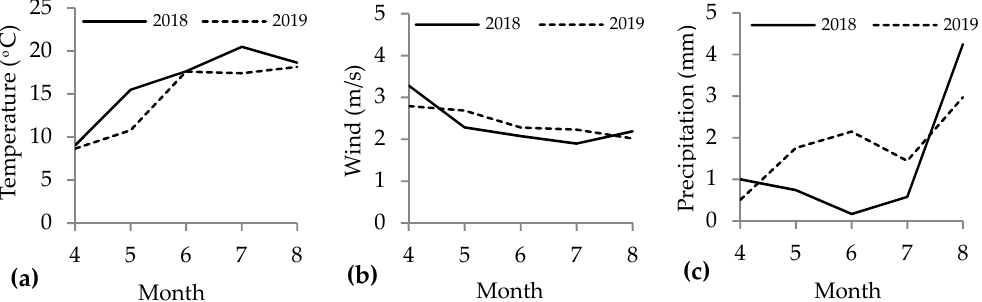
Figure 2. Weather data during the experiments: ( a ) temperature, ( b ) wind and ( c ) precipitation. Measurement height: 2, 2 and 1.5 m above ground level for temperature, wind and precipitation, respectively.